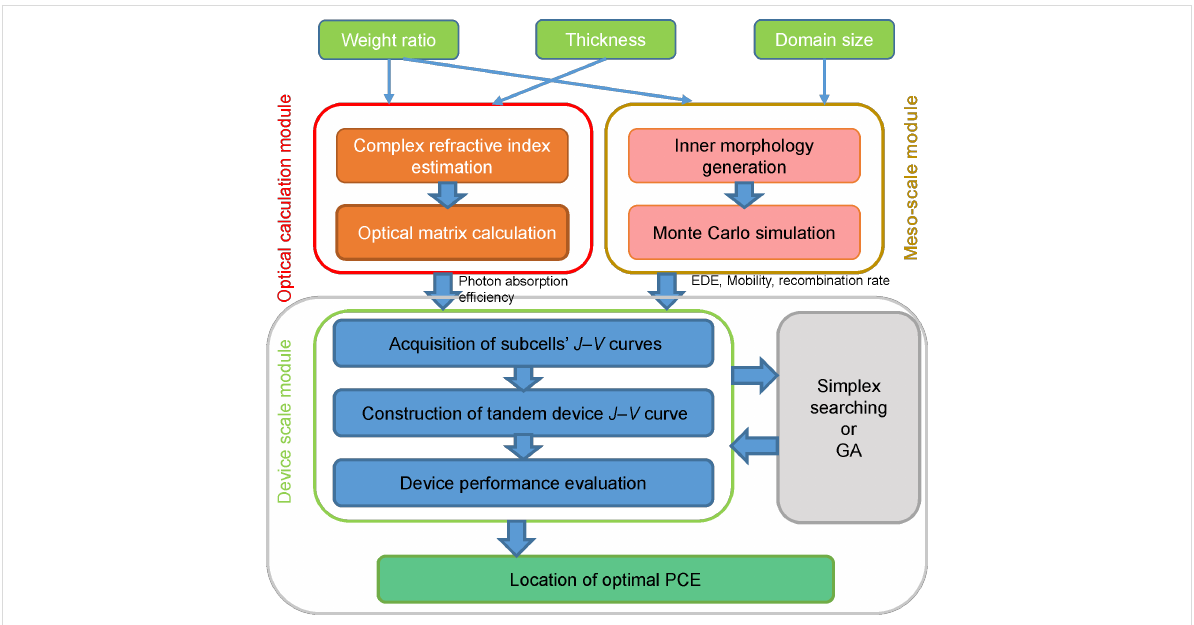
Figure 2: Schematic of the proposed simulation strategy for investigation and optimization of organic solar cells.